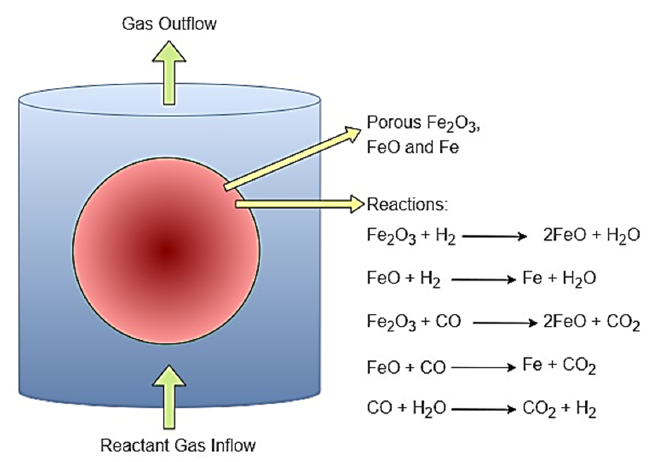
Figure 10. 2D-axisymmetric model description showing reactions and gas flow.